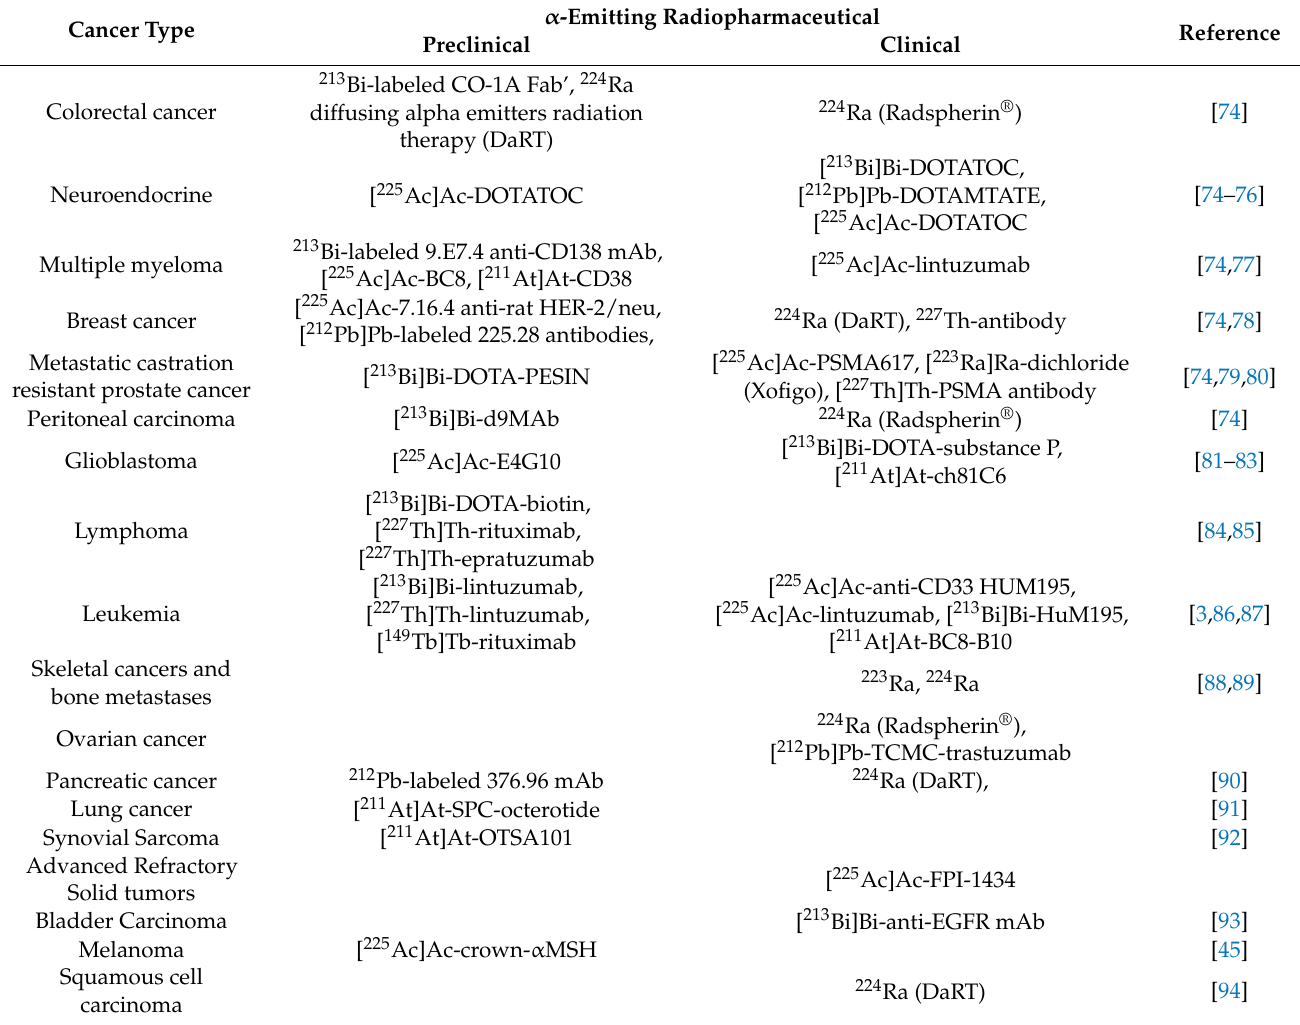
Table 5. Preclinical investigations and clinical applications of α -emitting